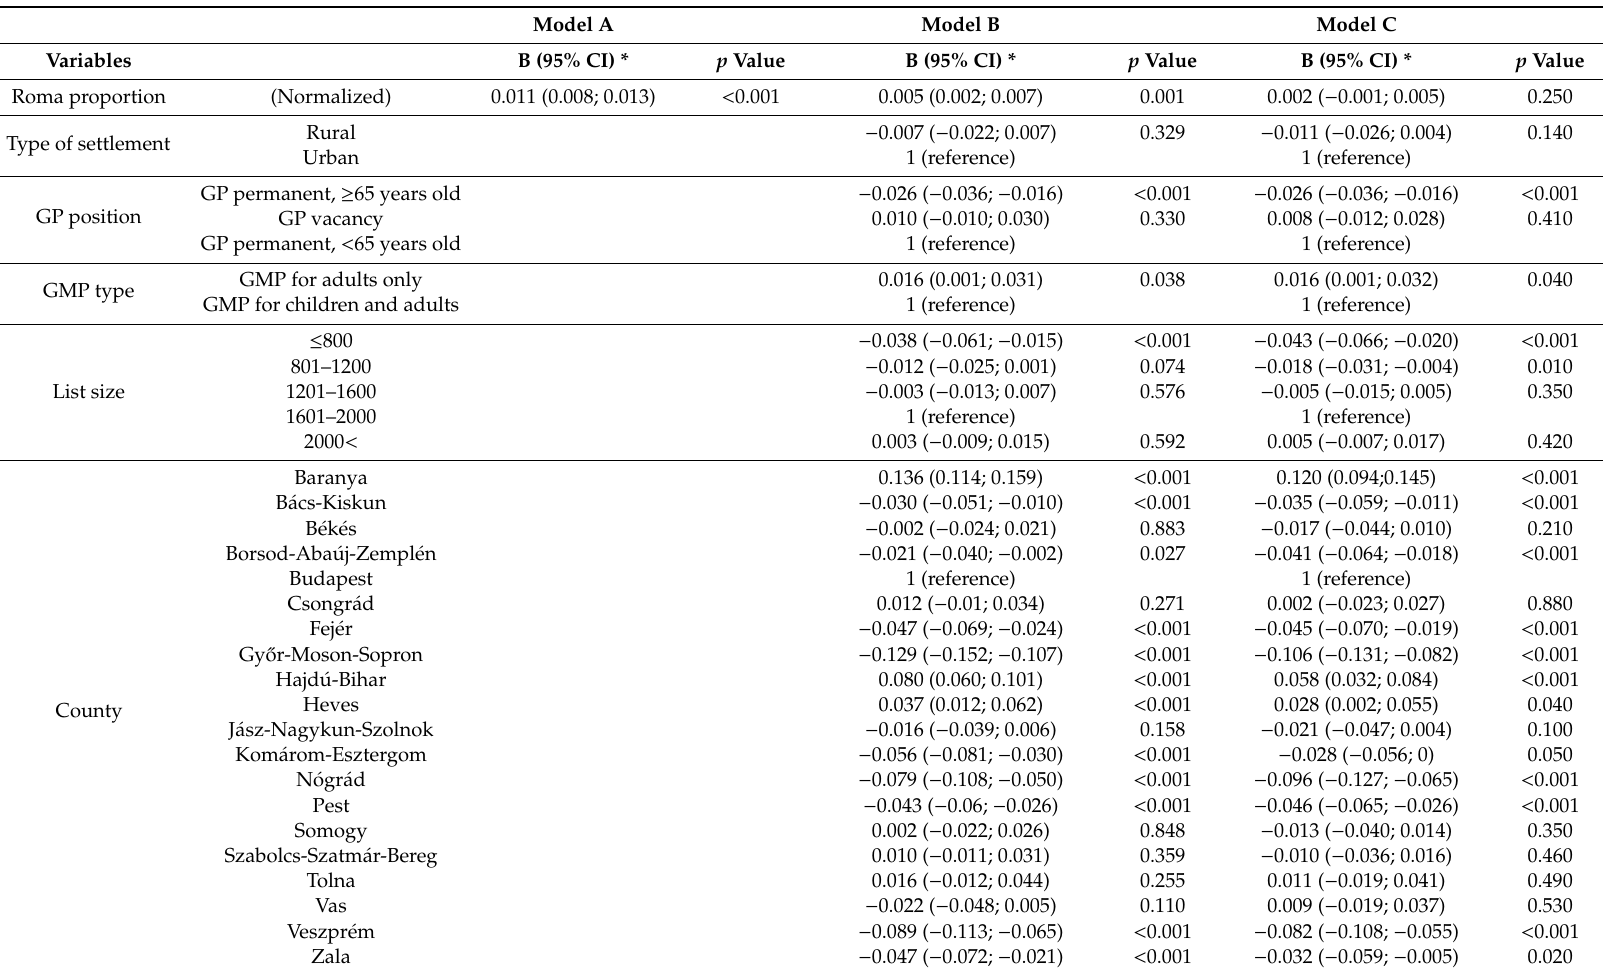
Table 3. Association between the proportion of Roma people in the population served by a GMP and standardized normalized average per-capita expenditures of the National Health Insurance Fund in Hungary estimated with linear regression models controlling for the socioeconomic status of patients and the structural characteristics of